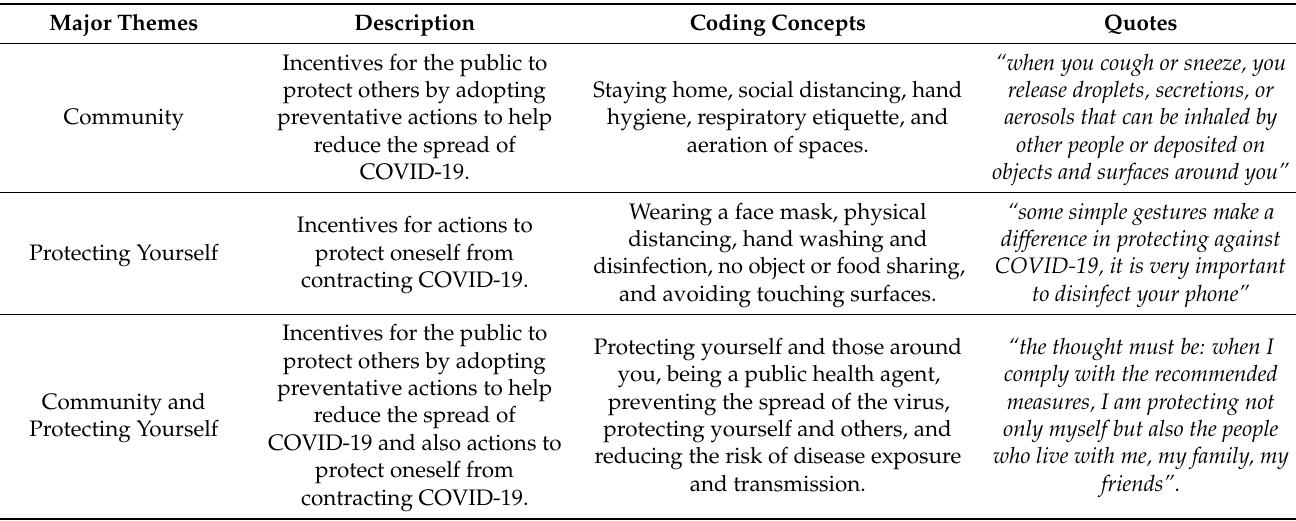
Table 2. Major themes from health entities’ posts on social